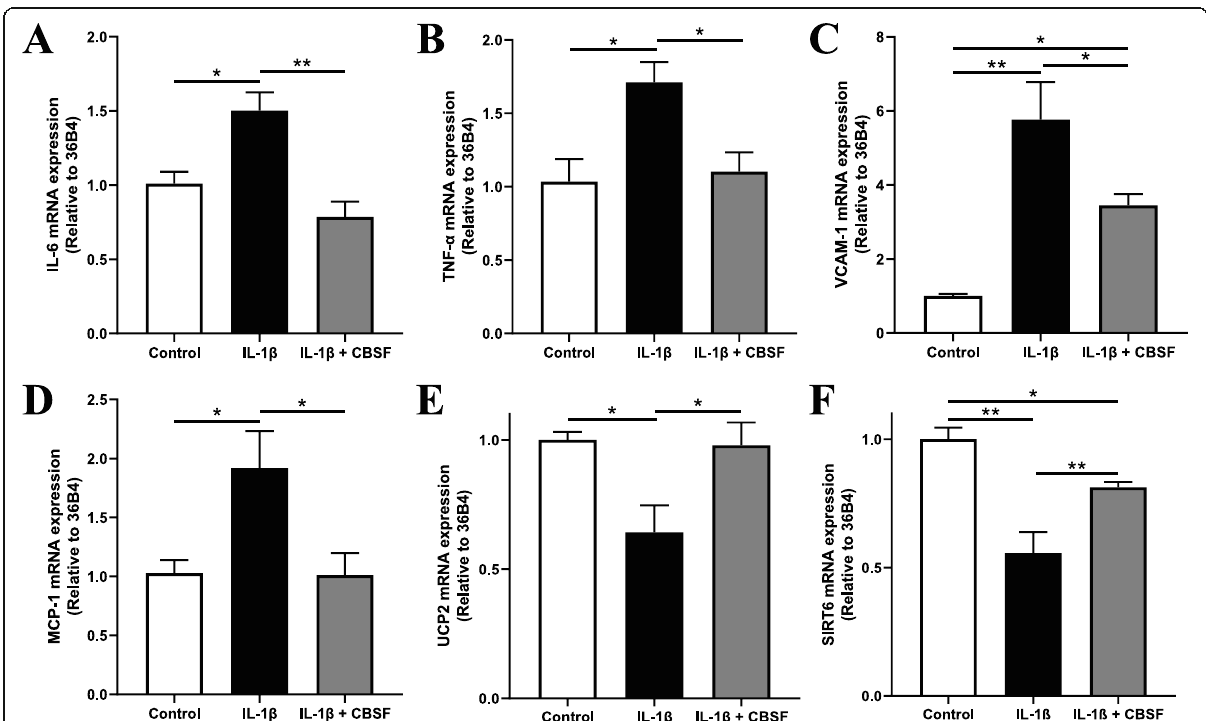
Fig. 7 CBSF co-incubation reversed the gene expression levels of pro-inflammatory cytokines, SIRT6 and UCP2 skewed by IL-1 β in endothelial cells. Effect of IL-1 β (1 pg/mL) and CBSF (0.2 μ g/mL) on the mRNA levels of IL-6 ( a ), TNF- α ( b ), VCAM-1 ( c ), MCP-1 ( d ), UCP2 ( e ) and SIRT6 ( f ) in mBMECs. Data are presented in means ± SEM; n = 4 – 6, * p < 0.05, ** p < 0.01. CBSF, crocodile blood soluble